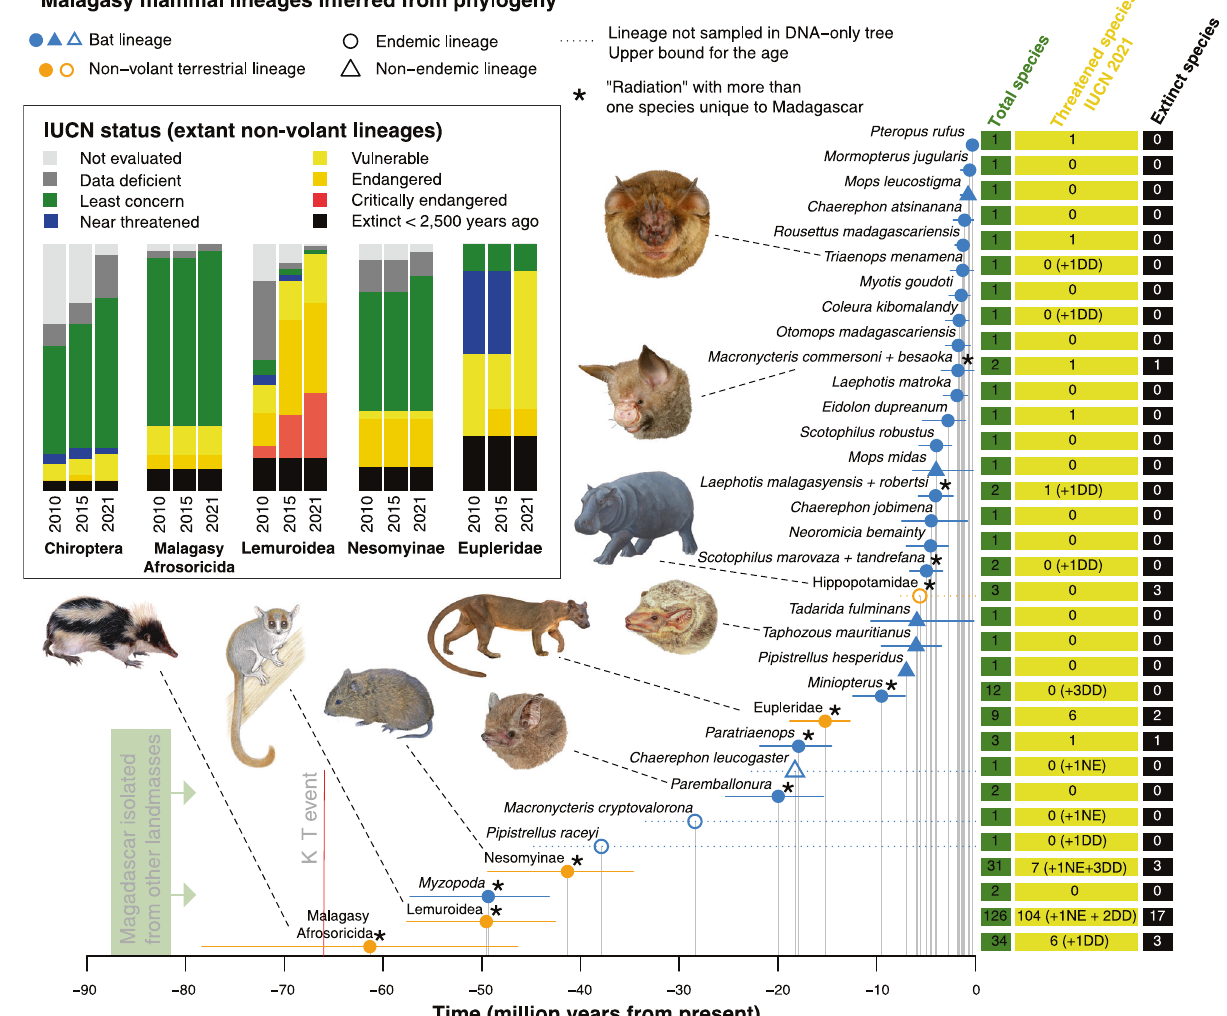
Fig. 1 | Mammalian lineages present on Madagascar at the time of human arrival. Colonization times in millions of years (Myr) of all Malagasy non-marine mammalian lineages descending from separate colonization events inferred from thephylogeneticdata,assumingcolonizationscenario1.Basedon1000datedtrees from the posterior distribution of the mammal trees derived from 43 . Horizontal lines indicate 95% highest posterior density for the colonization times; fi lled sym- bols on top of the lines indicate the mean of the distribution ( n =1000). For cases forwhichthelineagewasnotsampledinthephylogenetictrees(dashedhorizontal lines), only a maximum age for the colonization event can be inferred (see Meth- ods).Forsuchcases,thesymbolsontopofthelinesaregivenforvisibilitypurposes